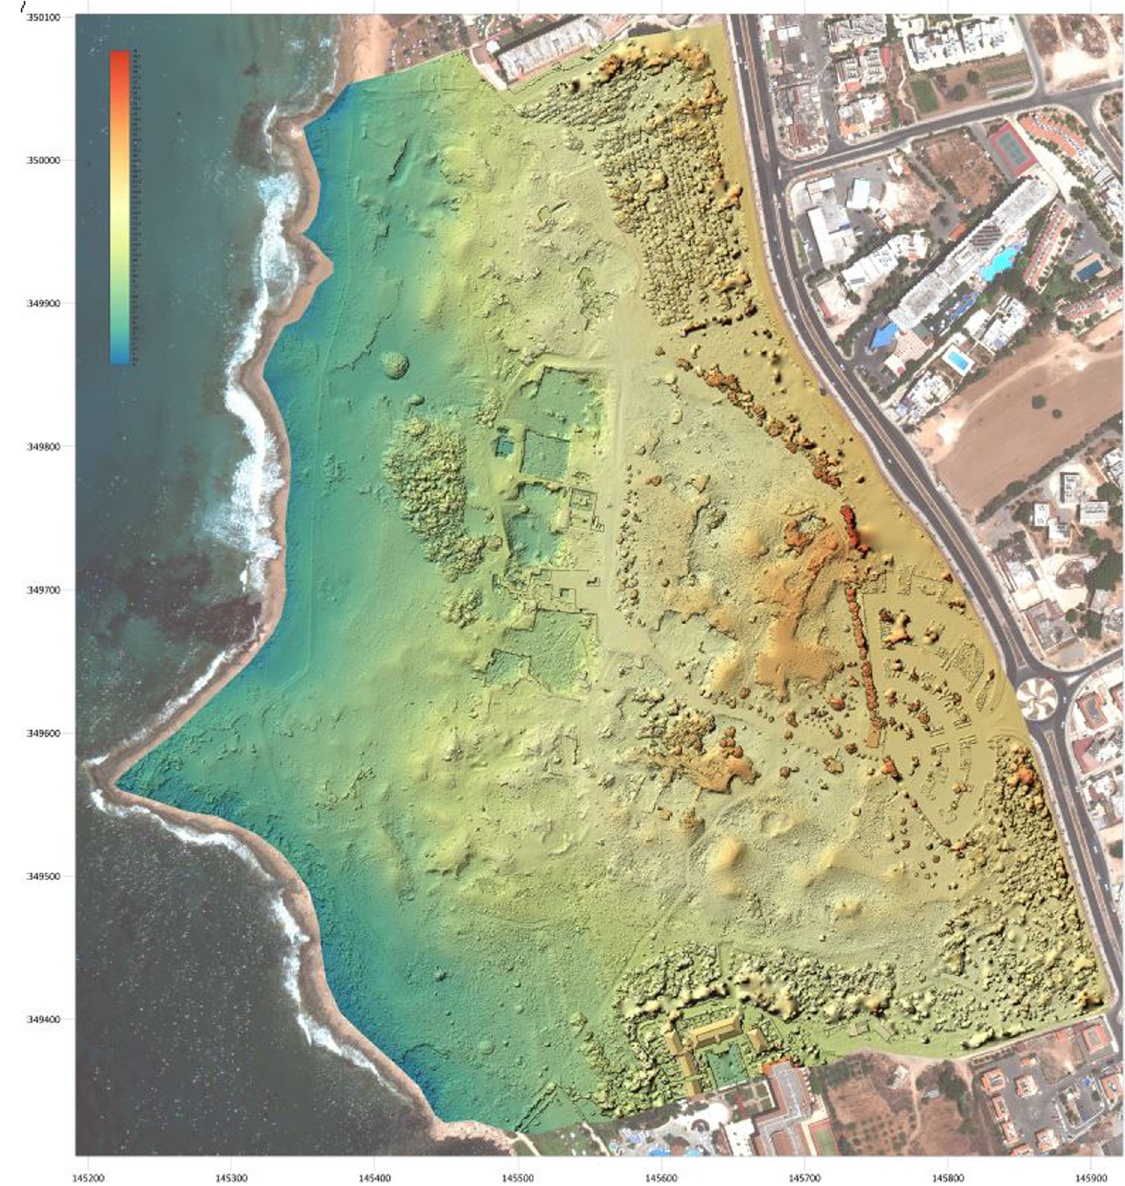
Fig. 16 Digital terrain model of one of the property ’ s components (Source: the